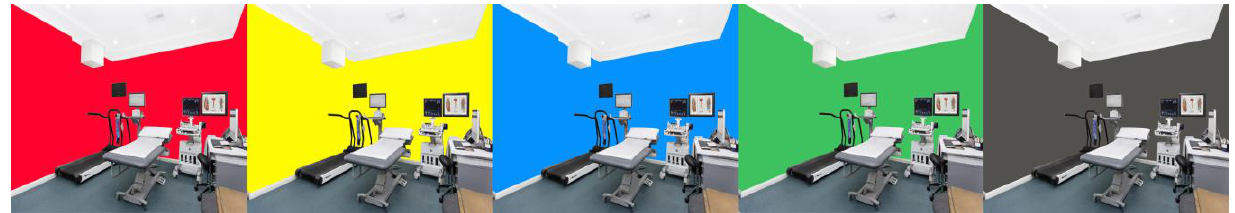
Figure 3. Color modalities of cardiology office